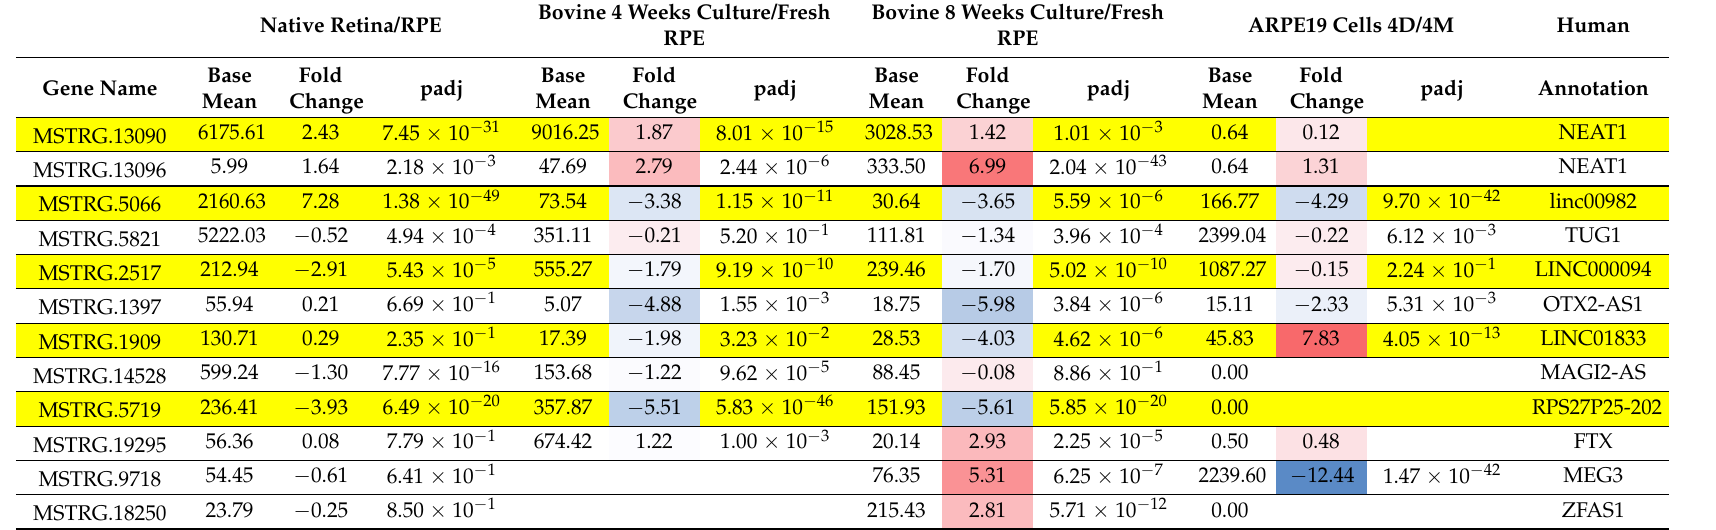
Table 2. lncRNAs conserved between human and bovine genomes and expressed in native